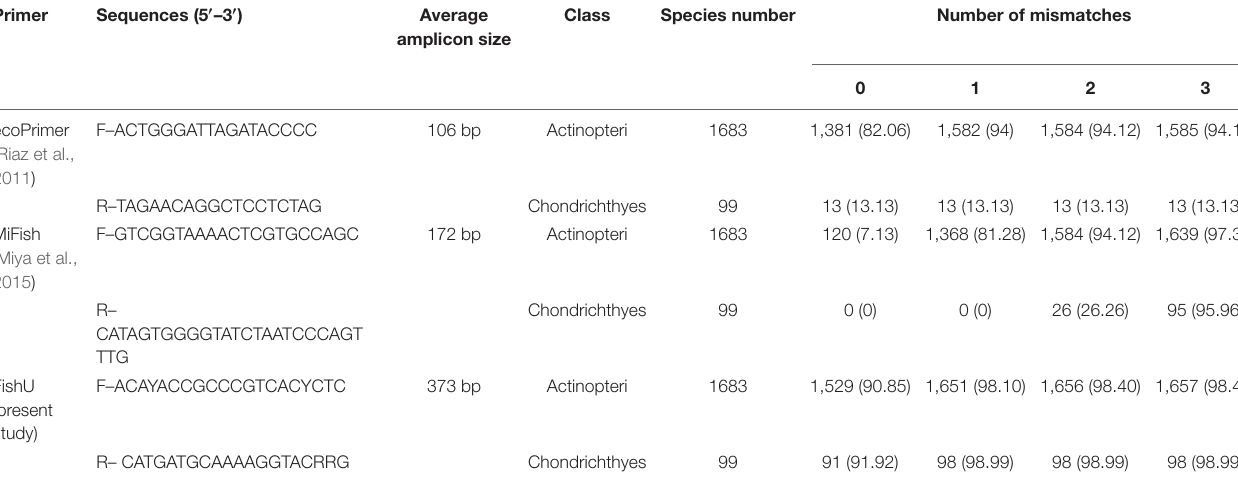
TABLE 1 | The numbers and percentage (in parentheses) of the amplified species by in silico PCR with three fish-specific universal primers. Primer Sequences (5 (cid:48) –3 (cid:48) )